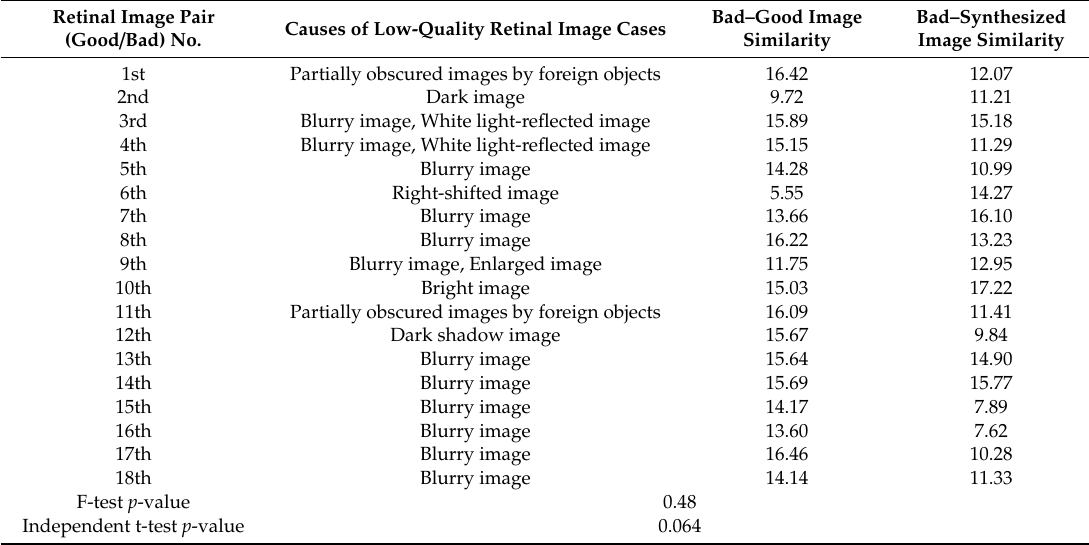
Table 2. Comparative analysis to validate synthetic images using Haralick algorithm. Retinal Image Pair (Good / Bad)